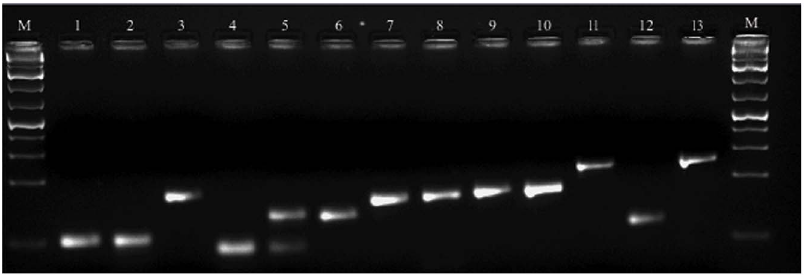
Figure 1. Agarose gel (3%) electrophoresis showing amplicon size for eleven candidate reference genes. M- O’GeneRuler TM 1 kb DNA Ladder Plus (Fermentas), 1- UBQ , 2- SAND , 3- ACT , 4- NTC VATP16 , 5- VATP16 , 6- PTB2 , 7- PSAB , 8- SMD3 , 9- EF1 a , 10– 60 S , 11- GAPDH , 12- NTC UQCC , 13- UQCC .